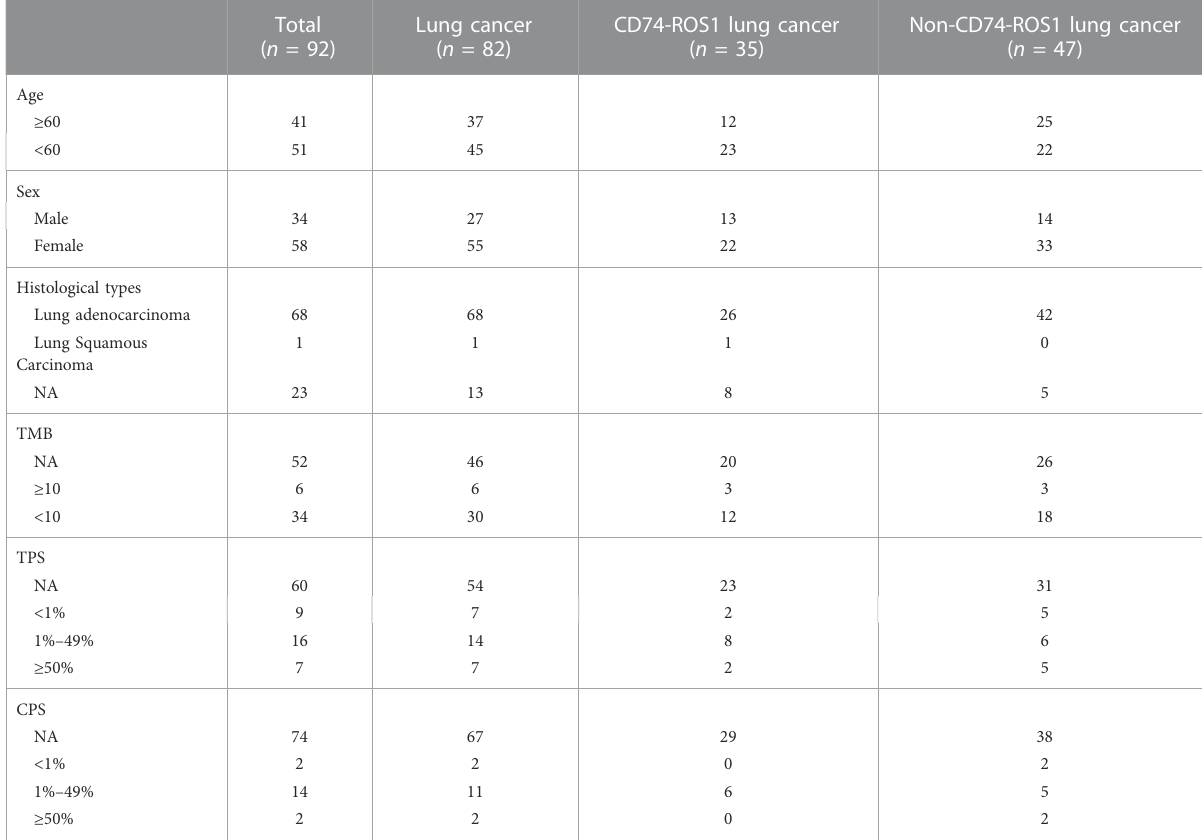
TABLE 1 Clinicopathologic features of patients with ROS1 rearrangement ( n =